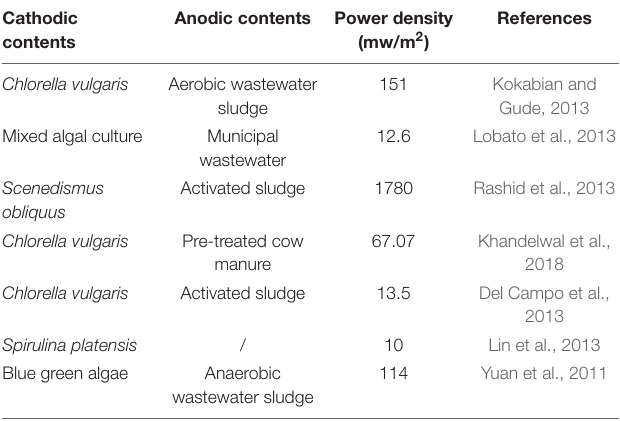
TABLE 1 | Electricity production of algal-based